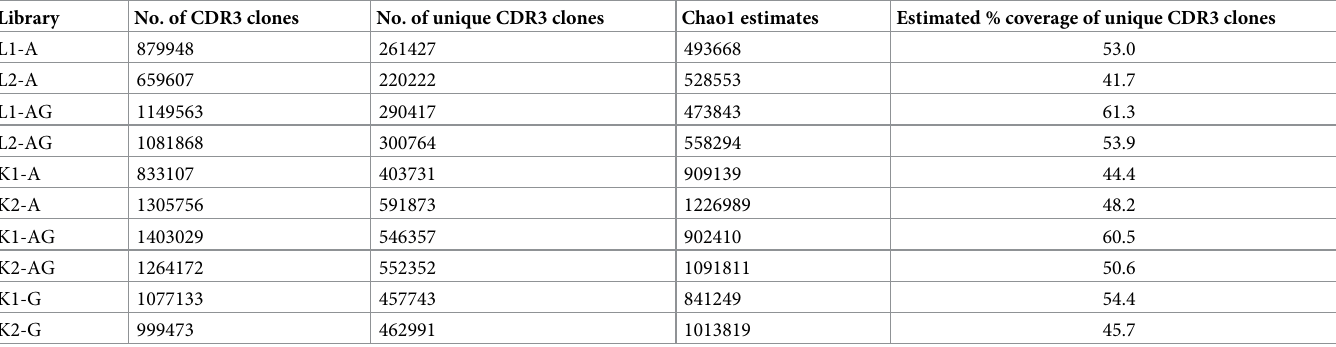
Table 2. Statistics of CDR3 clones. The last column is the percentage of Chao1 estimates covered by the unique CDR3 clones. Library No. of CDR3